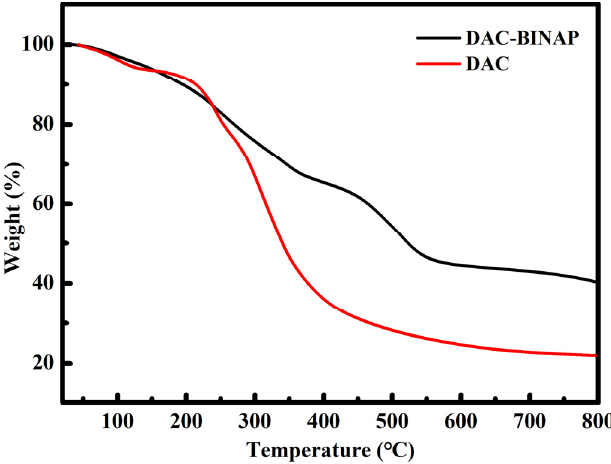
Figure 3. Thermogravimetric curves of DAC and DAC-BINAP. Rh(I) complexes are known to catalyze the hydrogenation of various unsaturated hydro- carbons, including alkynes [50]. XPS analysis is an effective tool for verifying the elemental composition of compounds. The characteristic peaks of C 1s, O 1s, N 1s, Rh 3d, and P 2p elements can be clearly seen in the XPS spectra in Figure 4a, which proves that Rh(COD) 2 BF 4 was successfully complexed with DAC-BINAP. The oxygen-containing functional group on the surface of DAC acts as an anchor point to fix Rh via electrostatic interactions, so that Rh(COD) 2 BF 4 was distributed on the surface of DAC-BINAP [51]. The binding energy peaks of Rh 3d 5/2 and Rh 3d 3/2 for Rh/DAC-BINAP were observed at 307.79 eV and 312.47 eV, respectively, as shown in Figure 4b, indicating the presence of Rh 0 [52].